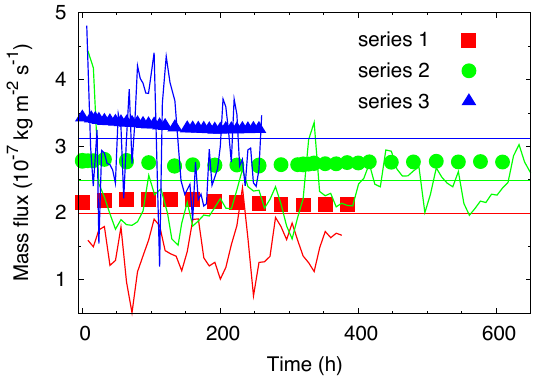
Fig. 9. Temporal evolution of the geometrical parameter “structure number” (S.N), which indicates the average number of intersec- tions/mm of a straight line through the snow.